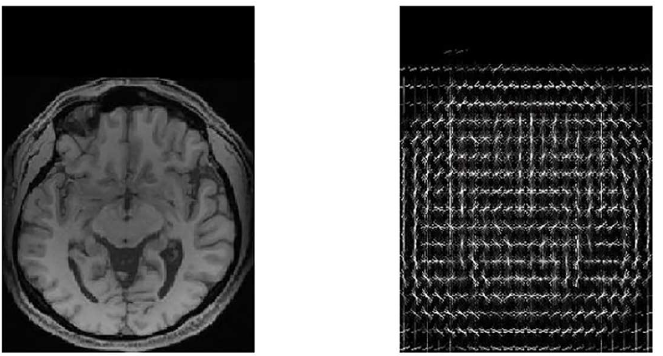
Fig 5. Input and output of 2D HOG on a brain image. The left panel shows an axial slice of a structural MR image of a brain. The right panel shows the HOG features of the same slice. Here, we represent the HOG features by an 8-sided“star”, where the lengthof each arm is the size of the histogramin that direction. This representation is generatedusing VLFeat